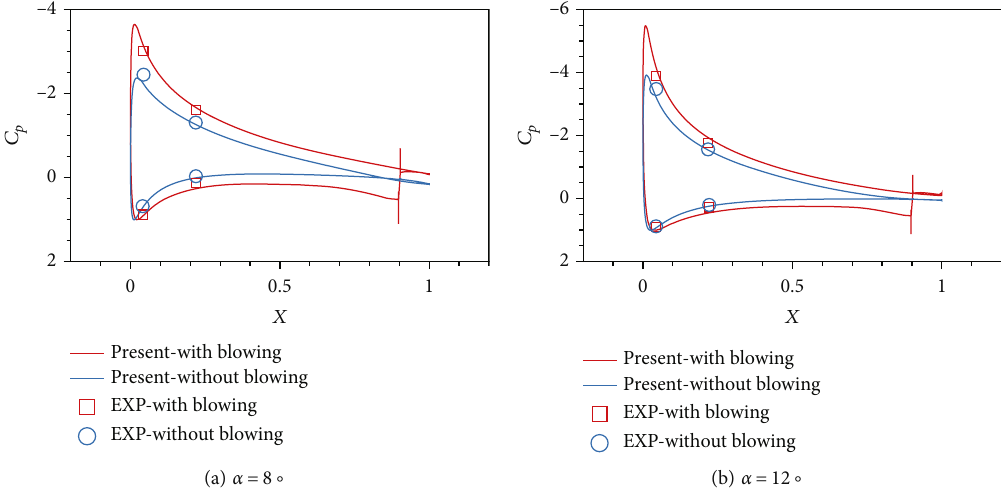
Figure 5: Pressure coe ffi cient distributions around the NACA0018